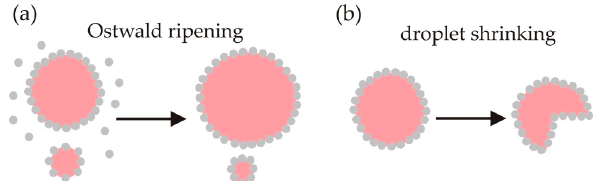
Figure 3. Pickering emulsions destabilise by mass transport due to ( a ) Ostwald ripening with small drops shrinking and larger drops swelling as molecules transfer from the small to the larger drops; and ( b ) all drops shrinking due to the liquid phases in the emulsion becoming partially miscible. The layer of particles coating shrinking drops buckle when the particles become jammed.